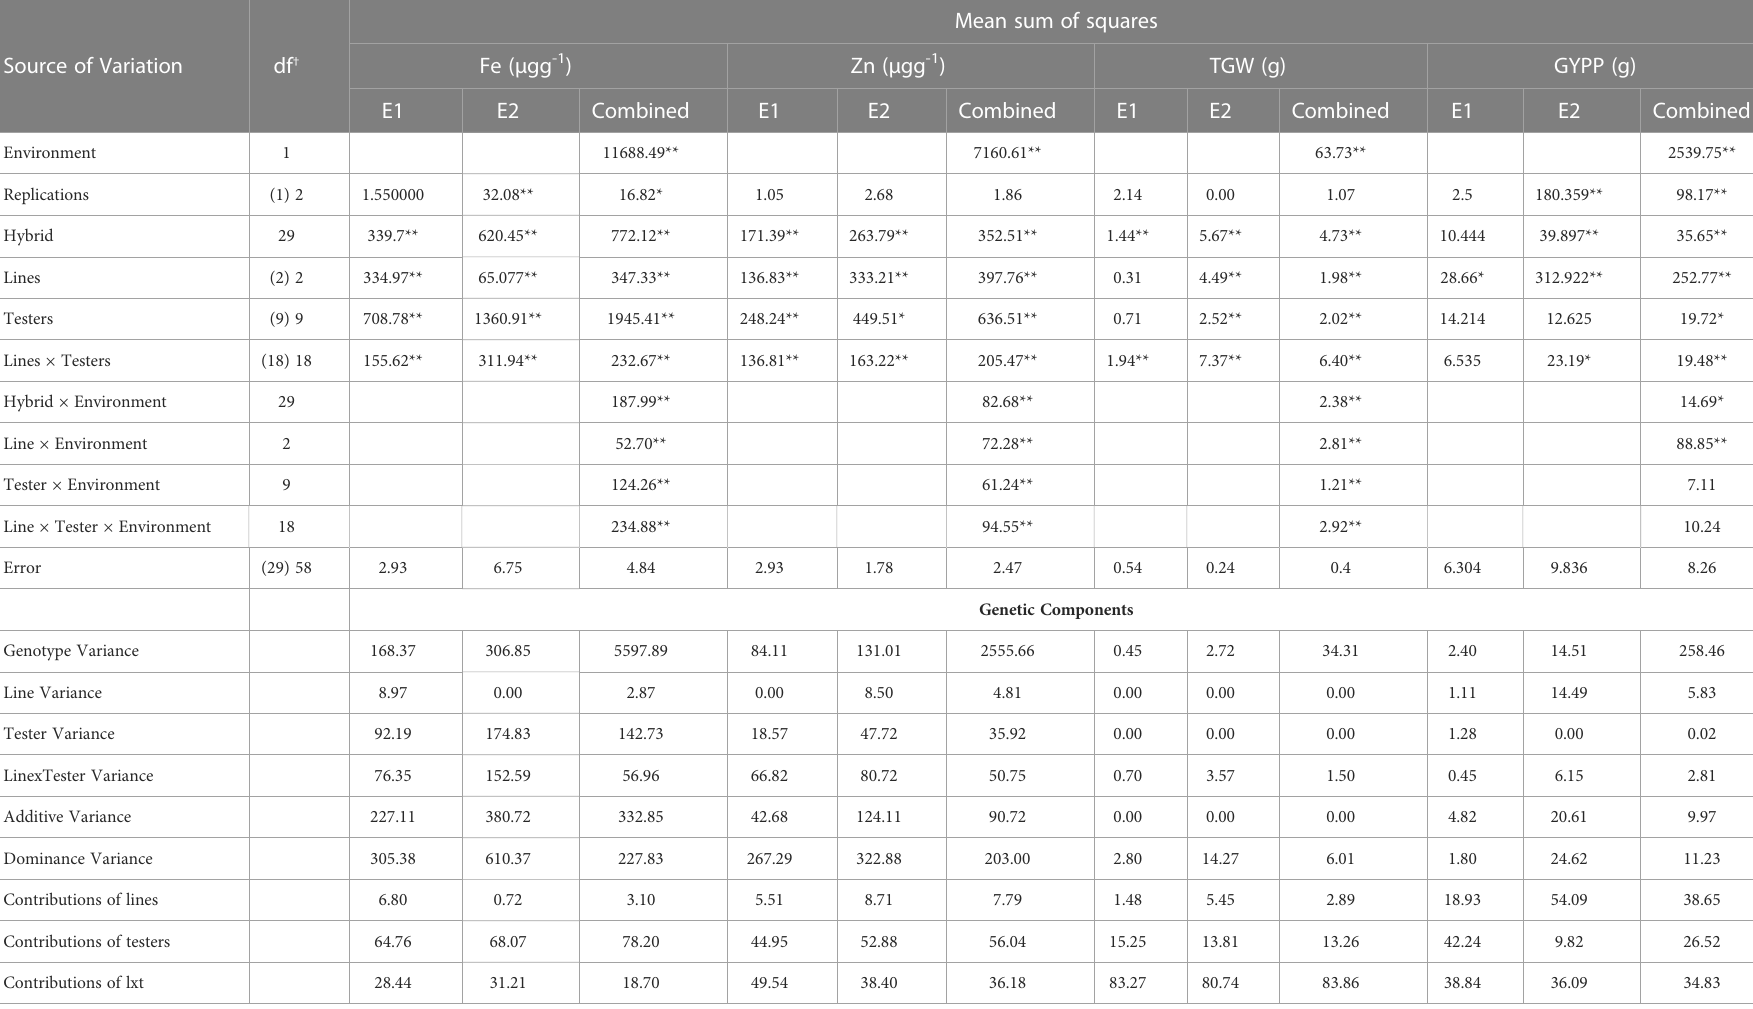
TABLE 2 Mean squares and genetic components for traits studied in line × tester trial of pearl millet in the 2019 summer season (E1) and 2019 rainy season (E2).